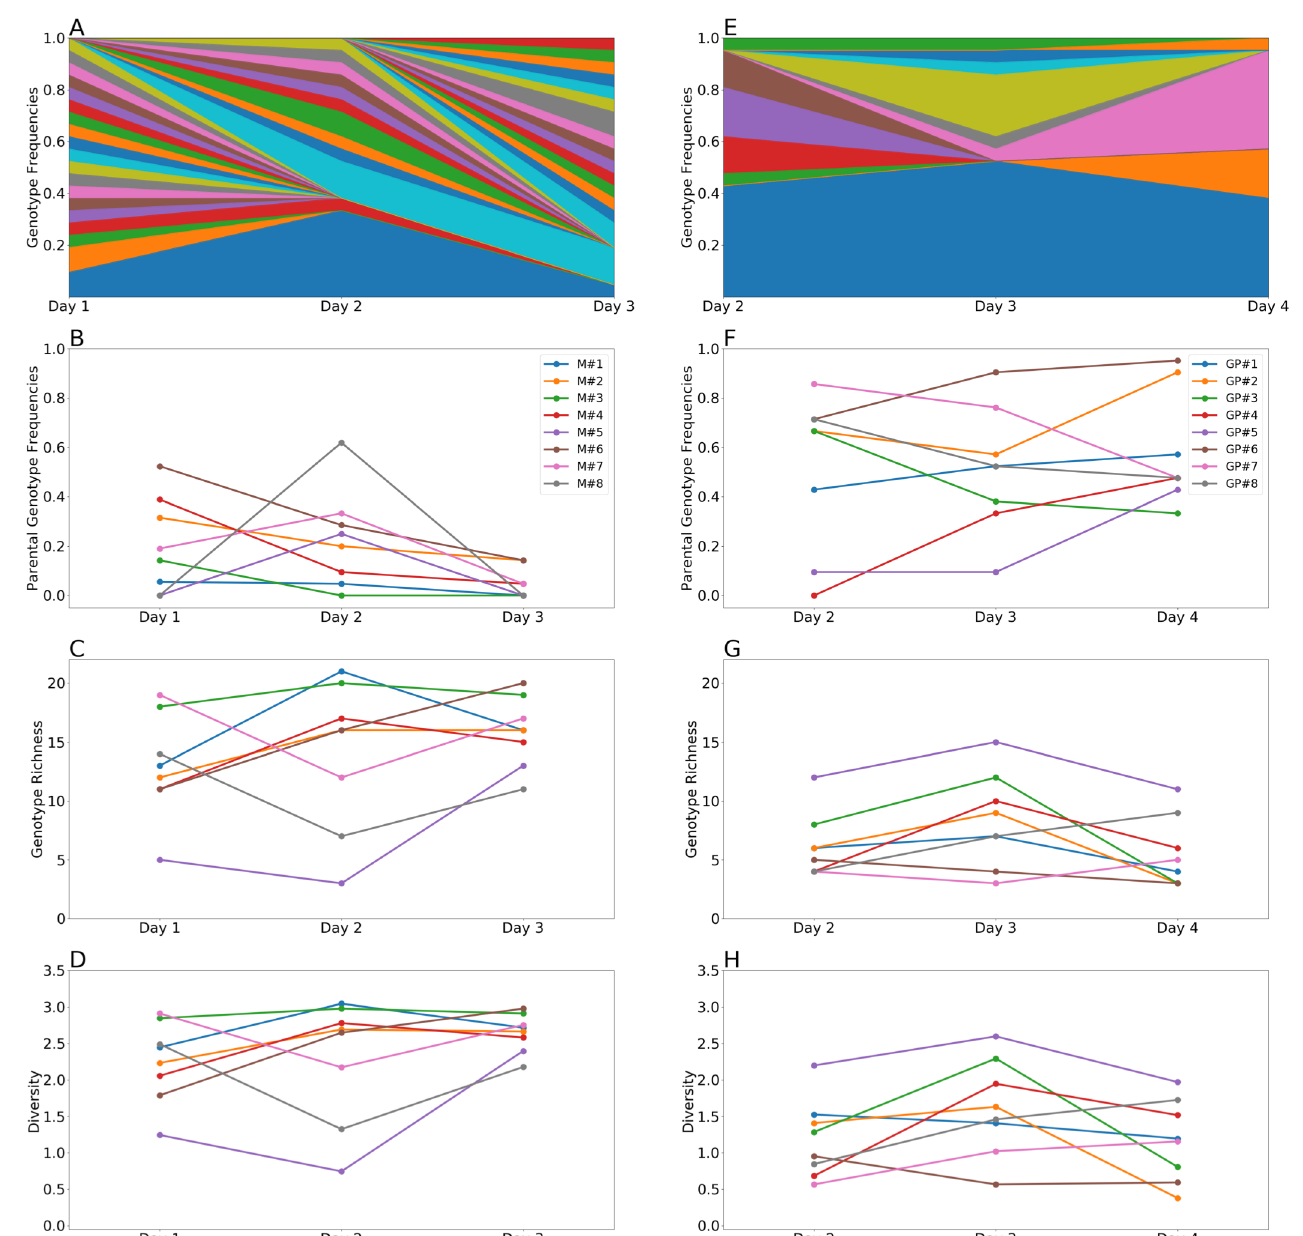
Figure 2. Viral populations in mallards showed lower frequencies of parental genotypes, higher genotype richness and higher diversity than those in guinea pigs. Results from mallards are shown in panels ( A – D ) and from guinea pigs in panels ( E – H ) Stacked plot showing frequencies of unique genotypes detected in one representative animal over time. The lowermost two sections, in blue and orange, represent the H3N8 and H4N6 parental genotypes, respectively. ( B , F ) Frequency of parental genotypes over time. The total frequency of H3N8 and H4N6 parental genotypes is plotted. ( C , G ) Genotype richness over time. ( D , H ) Diversity over time, as measured by the Shannon-Weiner